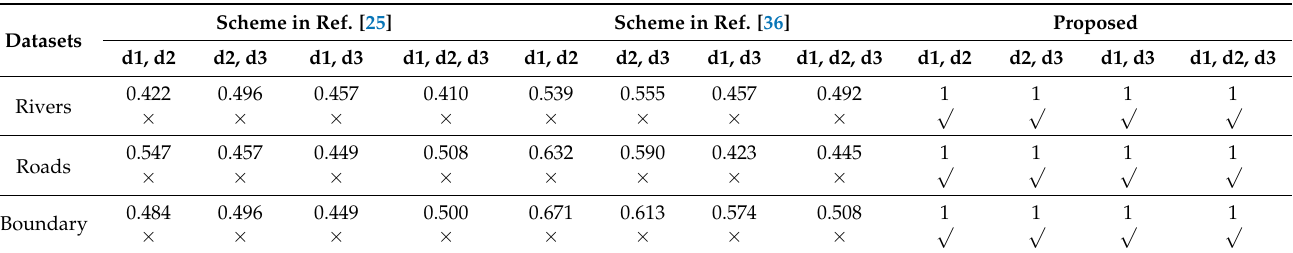
Table 5. The results of combination attacks.